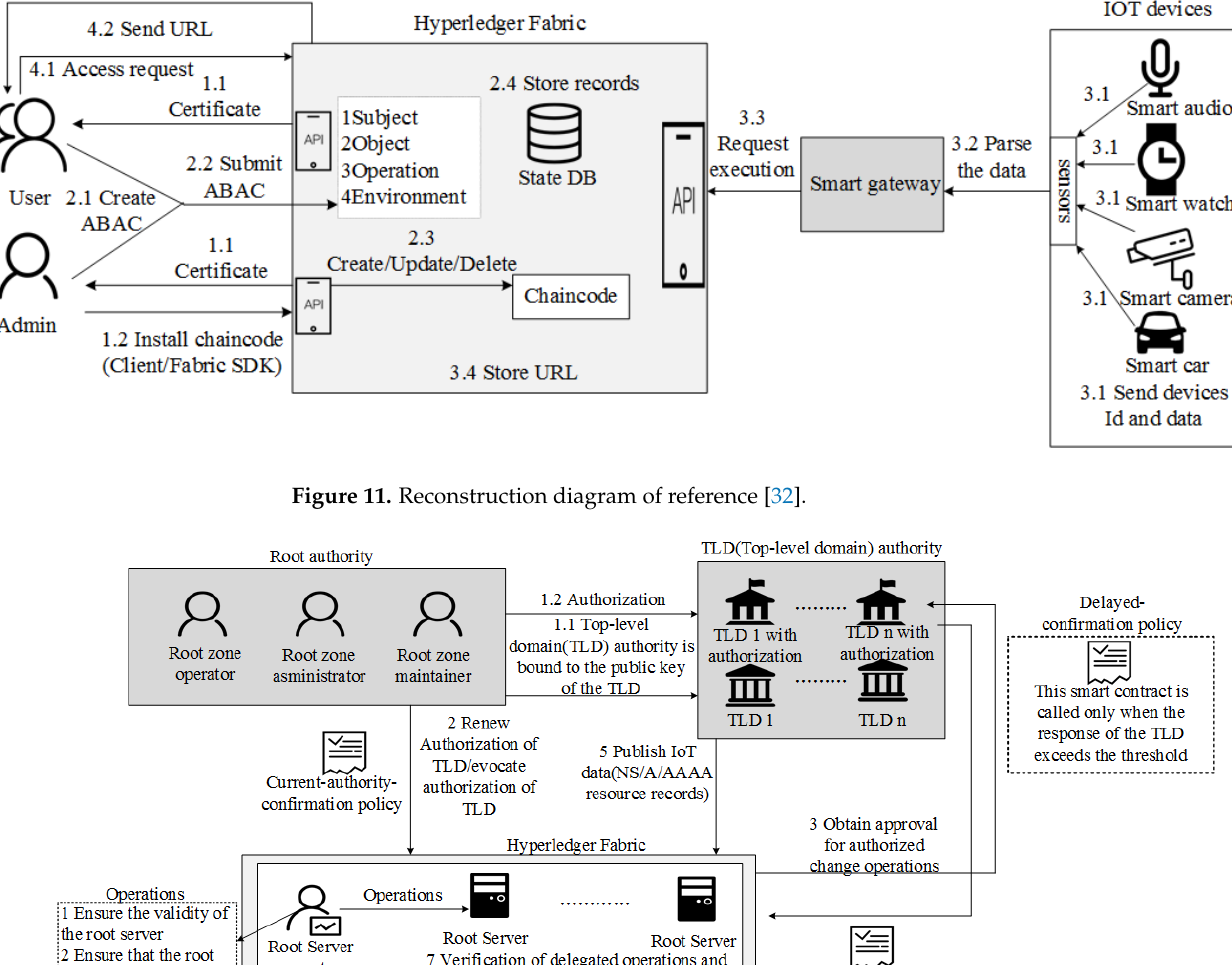
Figure 10. Reconstruction diagram of reference [31].